Question: Write a single sentence explaining what this figure depicts.
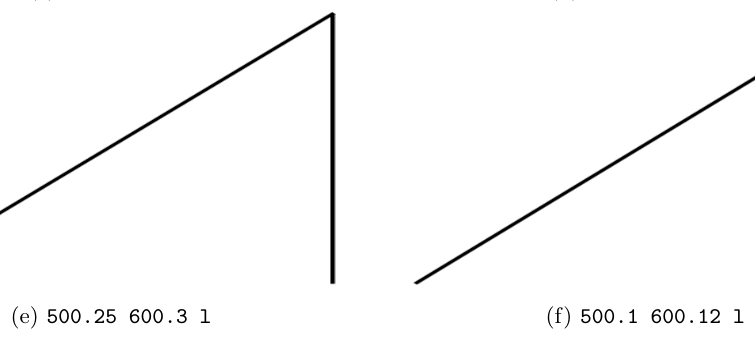
Answer: l Operator - control, 1%, 0.5%, 0.1% 0.05%, 0.02% (0.05%)